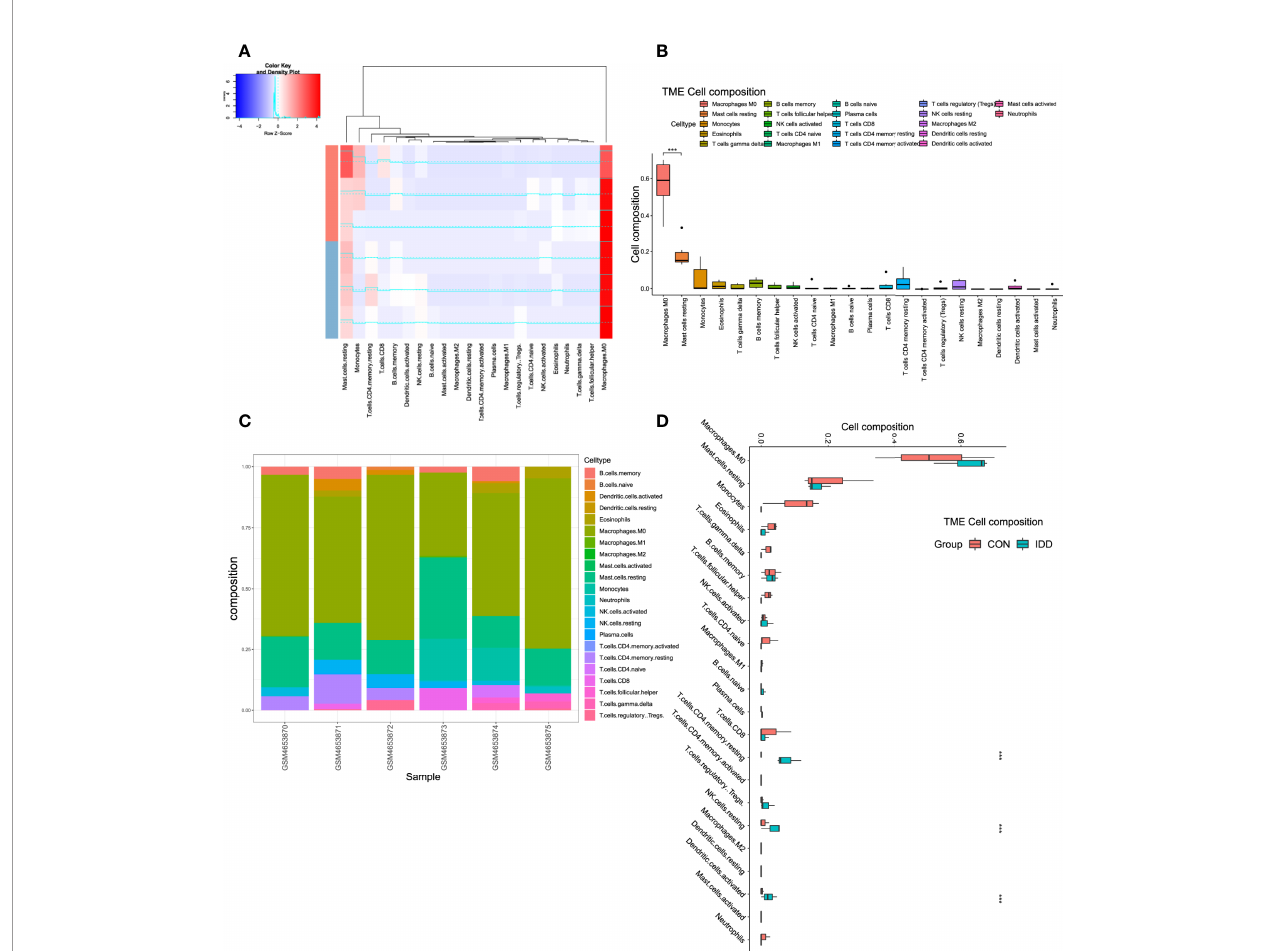
FIGURE 4 | Analysis immune landscape associated with DDD in CEP tissue. (A) , Heatmap visualizing the distribution of 22 types of immune cells in CEP tissue from normal and DDD patients. (B) , Box plot showing the whole composition of immune cells in these tissues. (C) , Pile-up histogram displaying proportion of immune cells in each sample. (D) , Differentially analysis of immune in fi ltration levels between normal and DDD